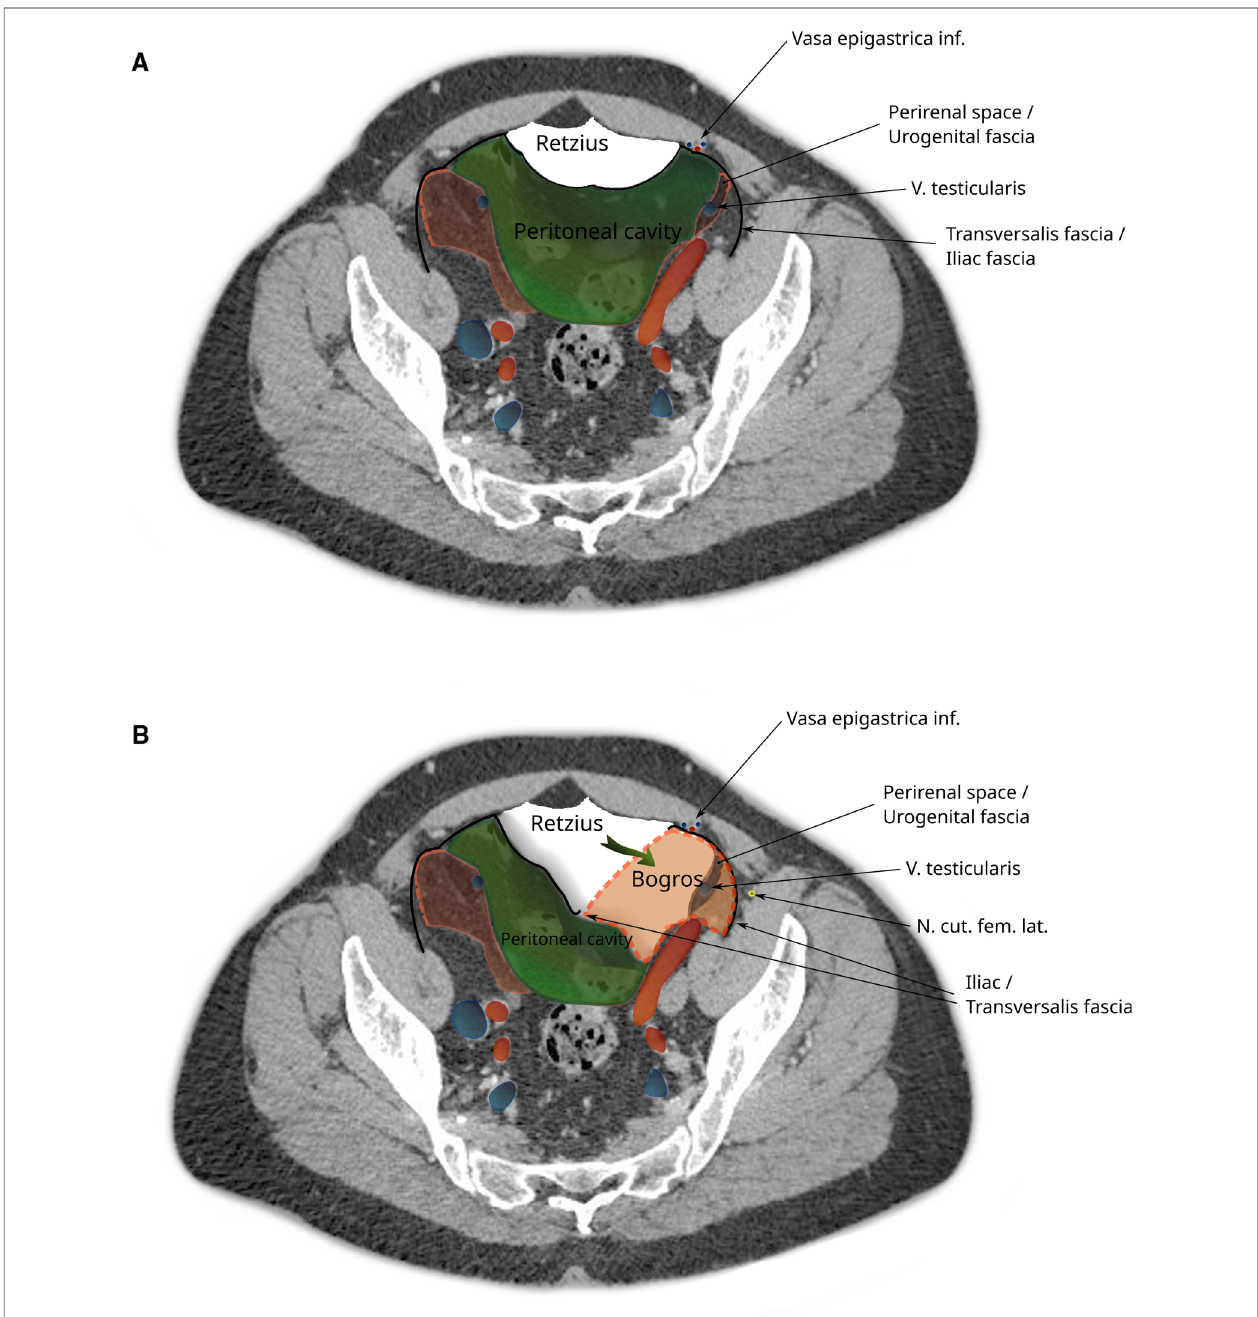
FIGURE 5 | CT image of the pelvis showing dissection during a total extraperitoneal hernioplasty (TEP). ( A ) The peritoneal sac is displaced and the space of Retzius dissected. ( B ) The space of Bogros is opened by cleaving the transversalis fascia. Note that the space of Bogros contains the spermatic vessels and tissues from the perirenal space enveloped by the urogenital fascia that extends from the abdomen into the